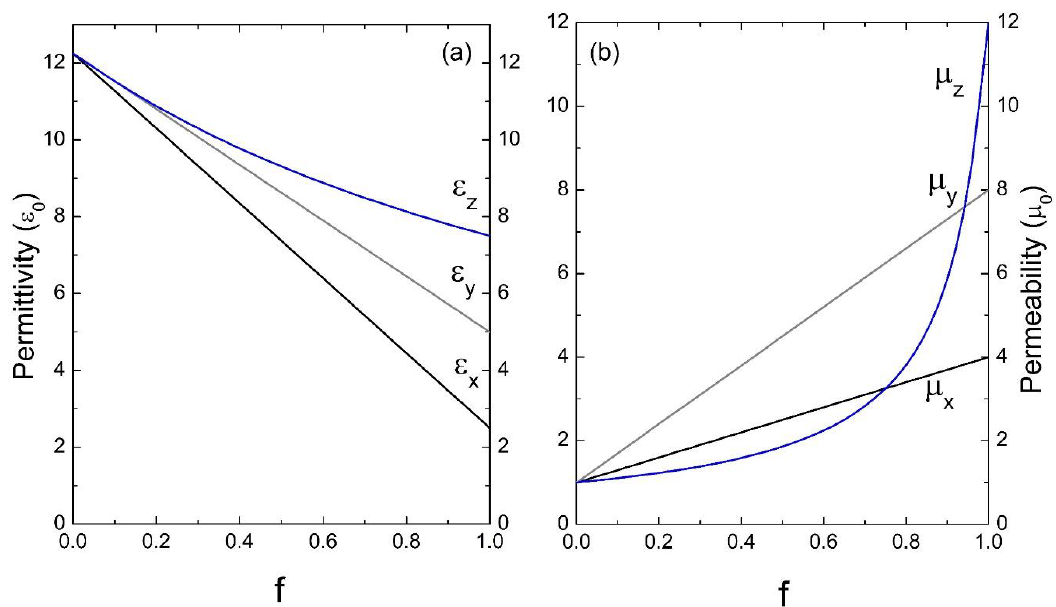
Figure 8. Permittivity ε ( a ) and permeability µ ( b ) versus the filling fraction f ( ε 0 and µ 0 are the units). The parameters used were: ε Ax = 2.5 ε 0 , ε Ay = 5 ε 0 , ε Az = 7.5 ε 0 , µ Ax = 4 µ 0 , µ Ay = 8 µ 0 , µ Az = 12 µ 0 and = 12.25 ε = µ ε µ B 0 , B 0